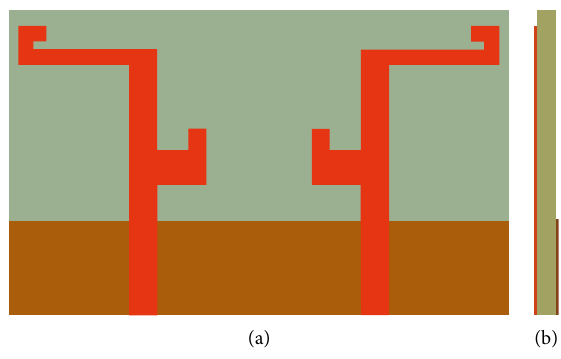
Figure 1: Structure of antenna#1 without NL: (a) perspective view and (b) end view.